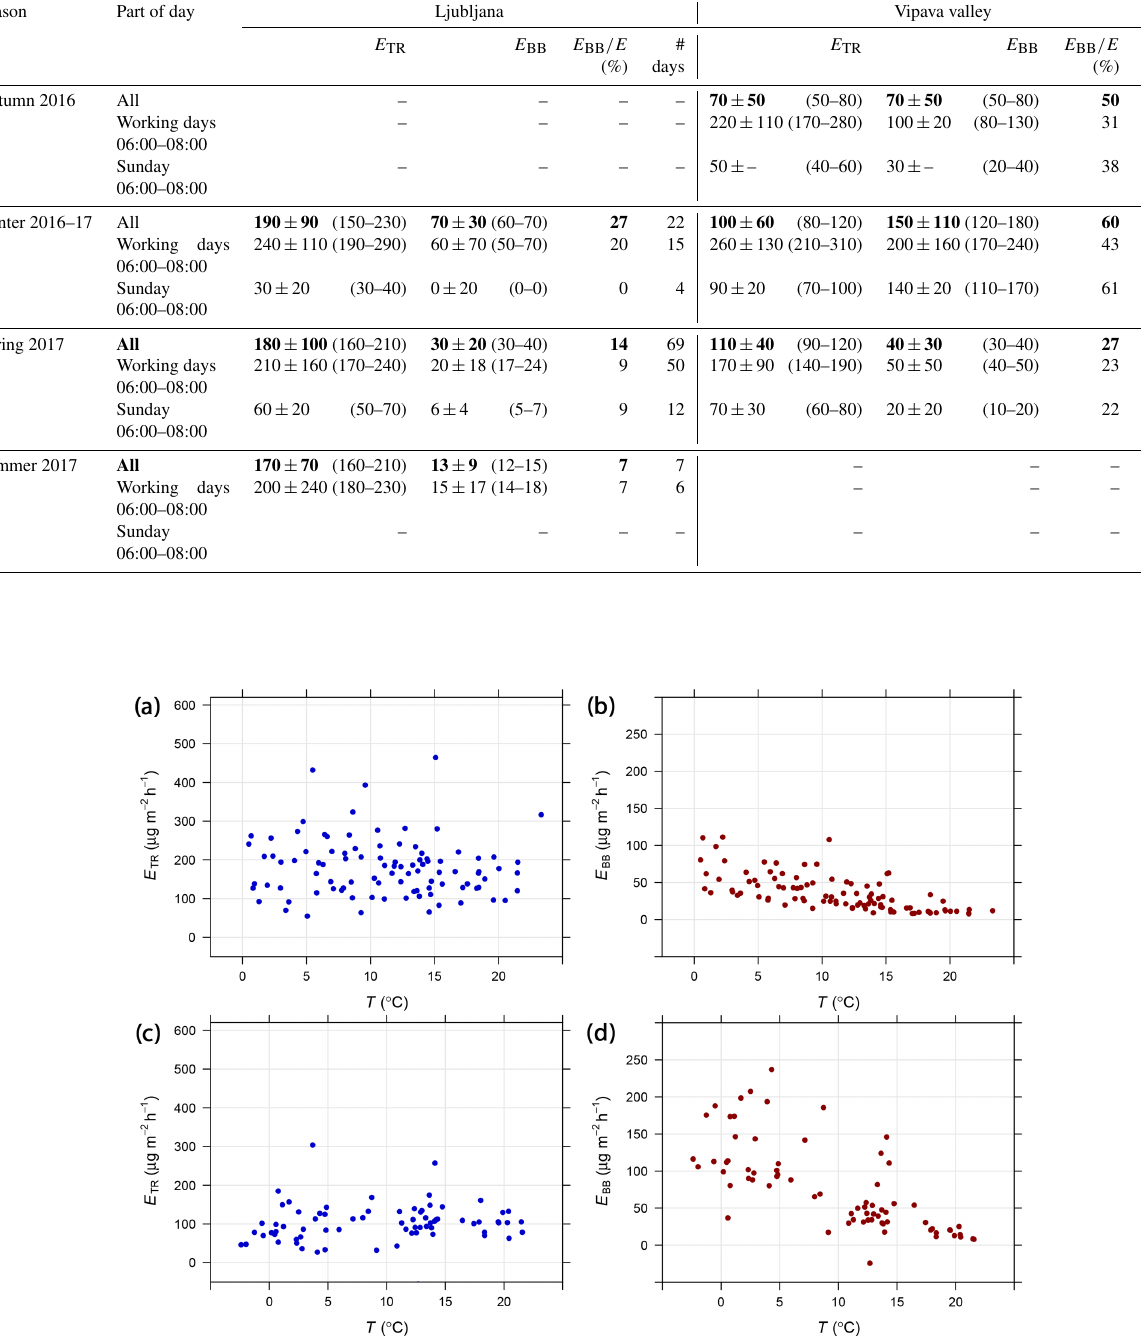
Figure 9. Dependence of source-specific emission rates E TR (traffic) and E BB (biomass burning) on the outdoor air temperature for Ljubljana (a, b) and Vipava valley (c, d) . Daily average values are